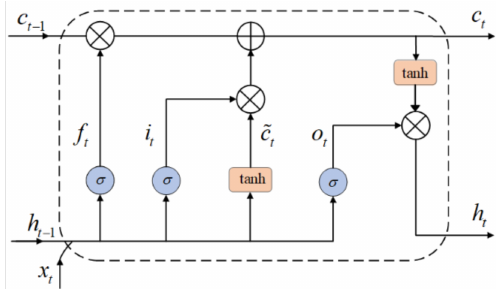
Figure 3. Long short-term memory cell